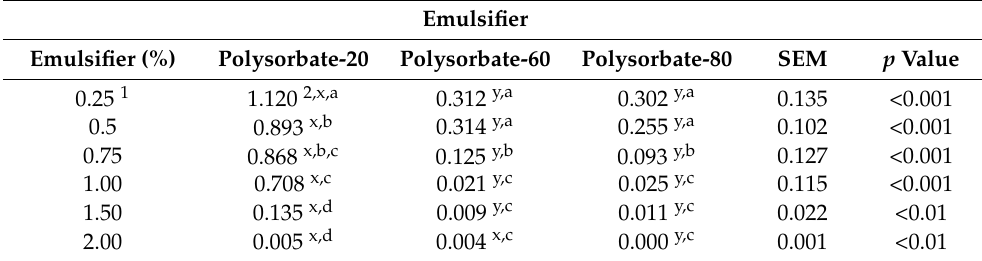
Table 2. Effects of different polysorbate emulsifiers and concentrations on the emulsification efficiency of